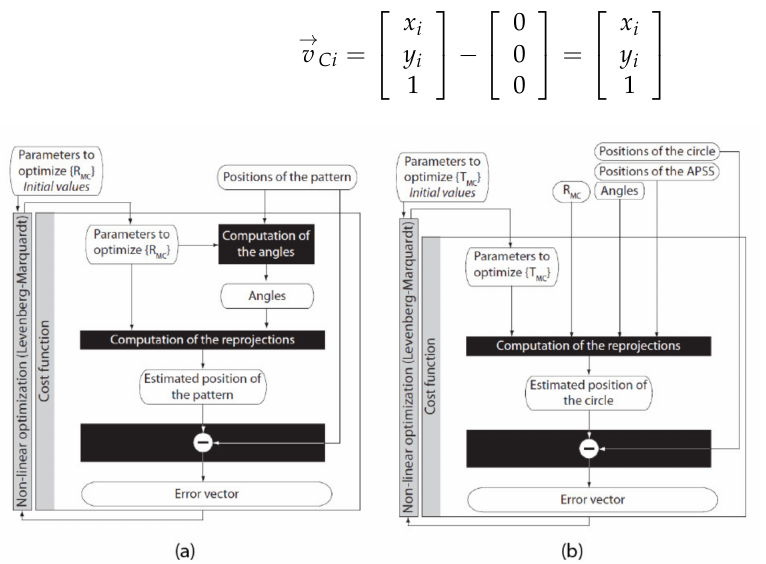
Figure 19. Details of the procedure for estimating R MC , the rotation component of E MC ( a ). Once R MC is found, it is used for estimating T MC , the translation component of E MC ( b ). These procedures correspond to Steps 3 and 4 in Figure